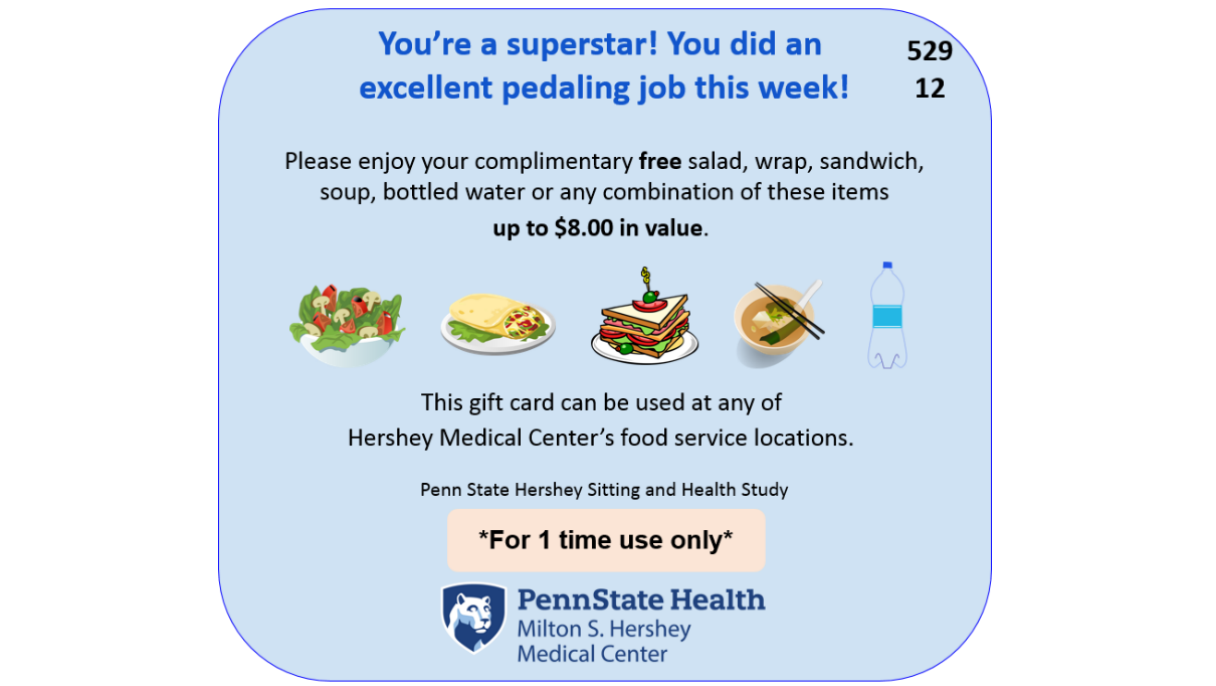
Figure 4. Sample e-gift card: Pedal4Food—Individual Contingent Immediate Reward